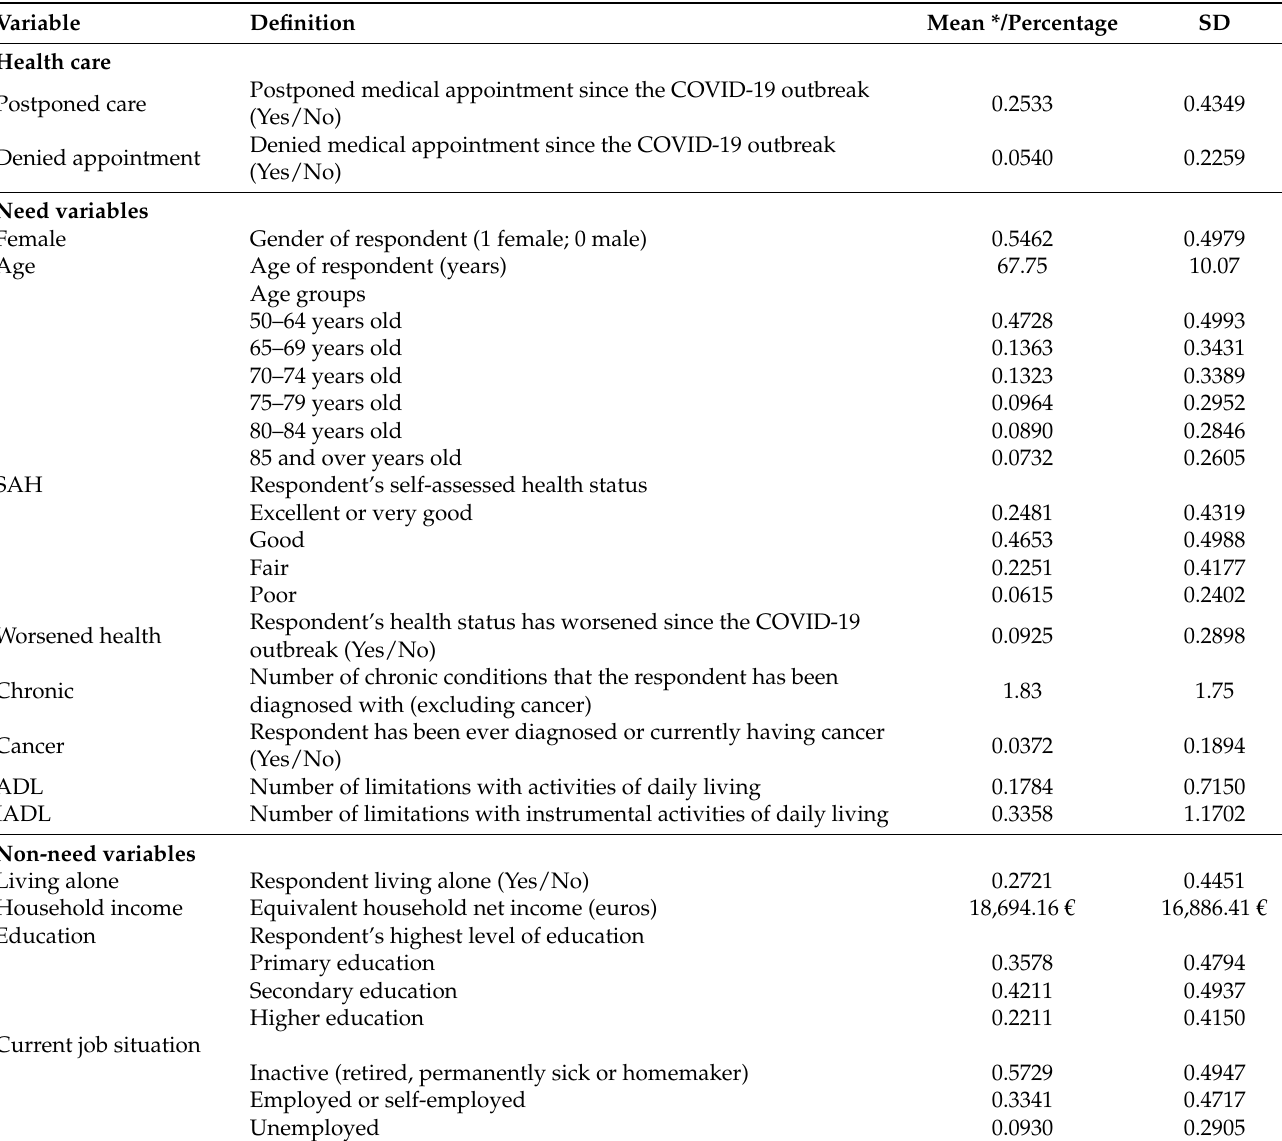
Table 1. Descriptive statistics for dependent and independent variables for the whole